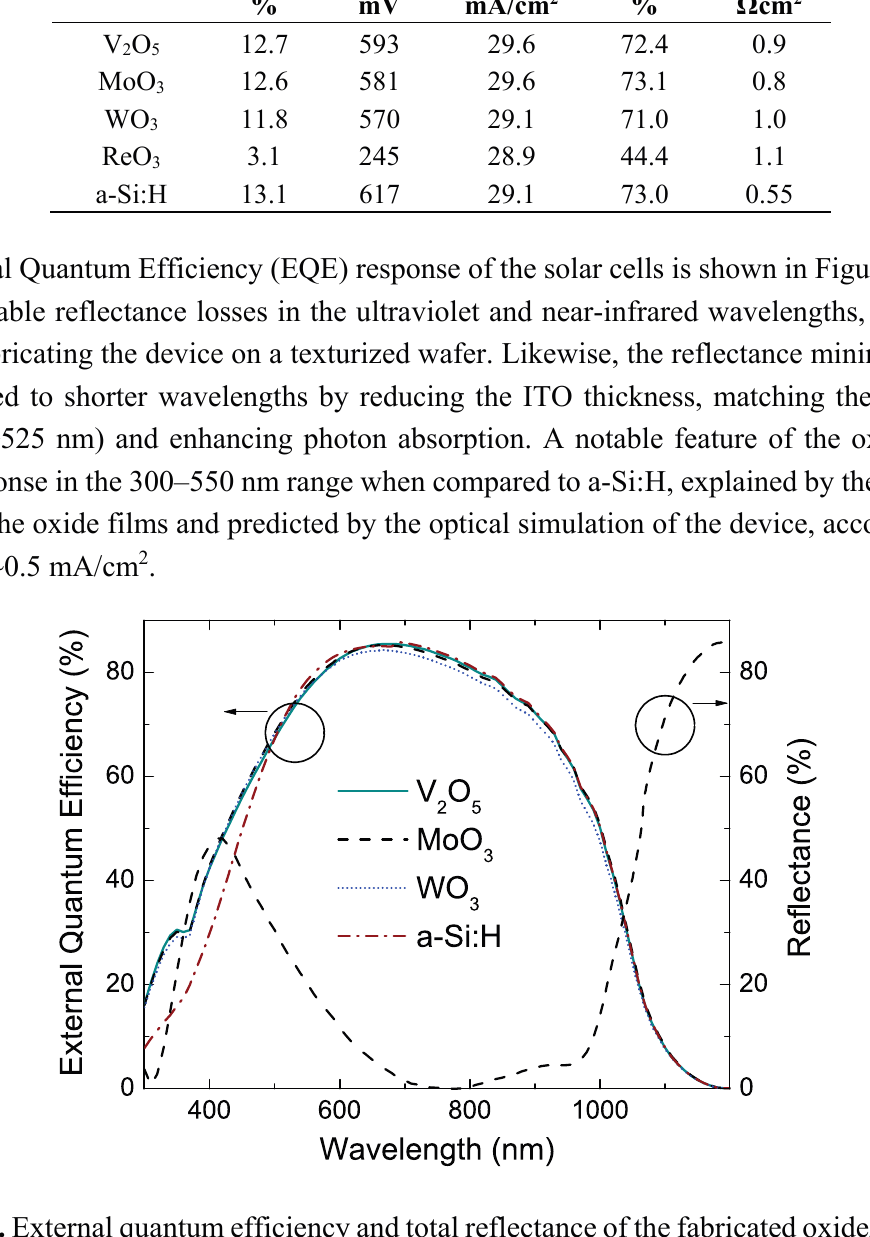
Figure 6. External quantum efficiency and total reflectance of the fabricated oxide/n-Si solar cells, including an a-Si:H reference